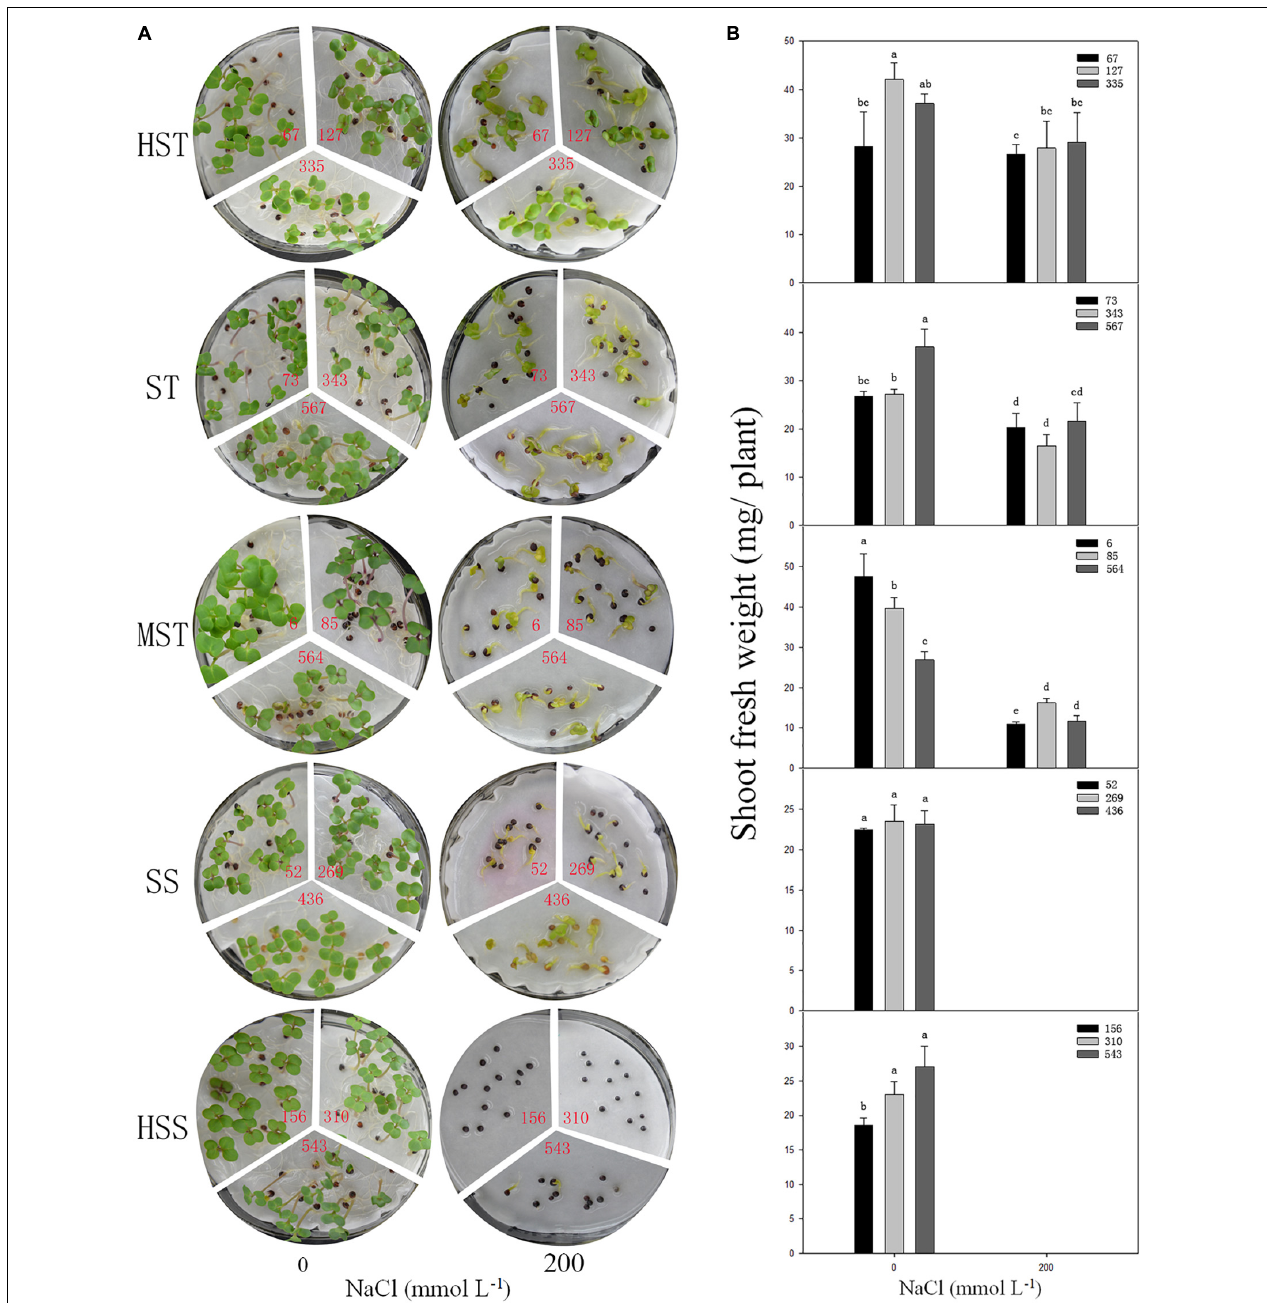
FIGURE 5 | Phenotypes (A) and shoot fresh weight (B) of the seedlings of different salt-tolerant B. napus inbred lines at 7 DAS under 200 mmol L − 1 . No. of HST (highly salt tolerant): 67, 127, and 335; ST (salt tolerant): 73, 343, and 567; MST (moderately salt tolerant): 6, 85, and 564; SS (salt sensitive): 52, 269, and 436; and HSS (highly salt sensitive): 156, 310, and 543 B. napus lines. Data are means ( n = 18) ± SD. Different letters indicate significant difference at P < 0.05.